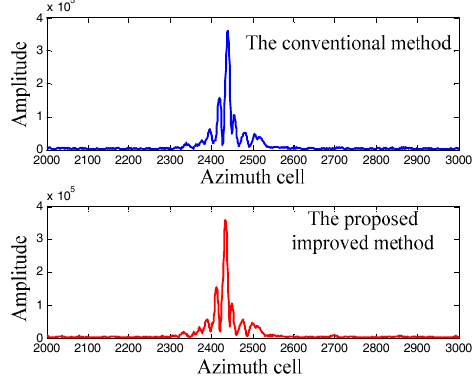
Figure 8. Moving target imaging results comparison.